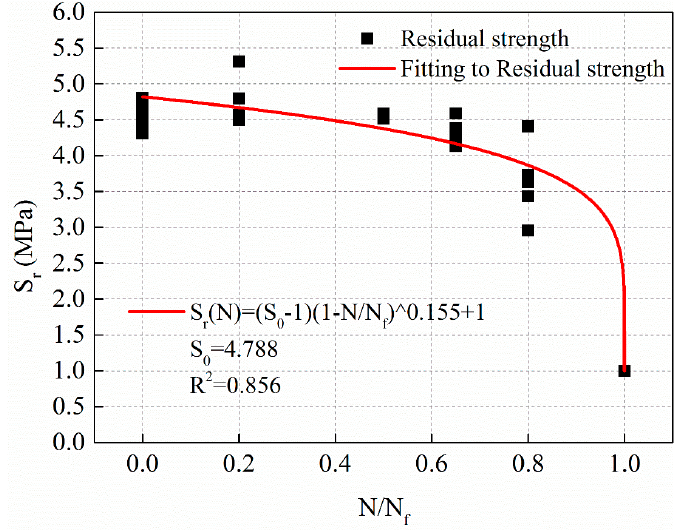
Figure 10. The decay law of residual strength with stress levels of 1 MPa.